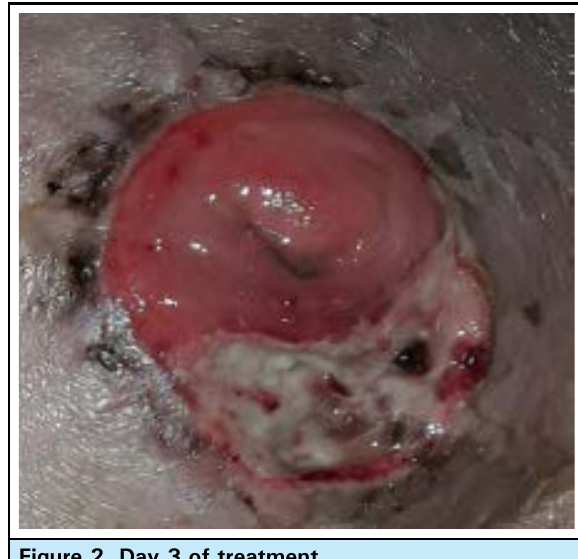
Figure 2. Day 3 of treatment. Patient was discharged after a week in a healthy condition with a maggot free stoma (Figure 3).